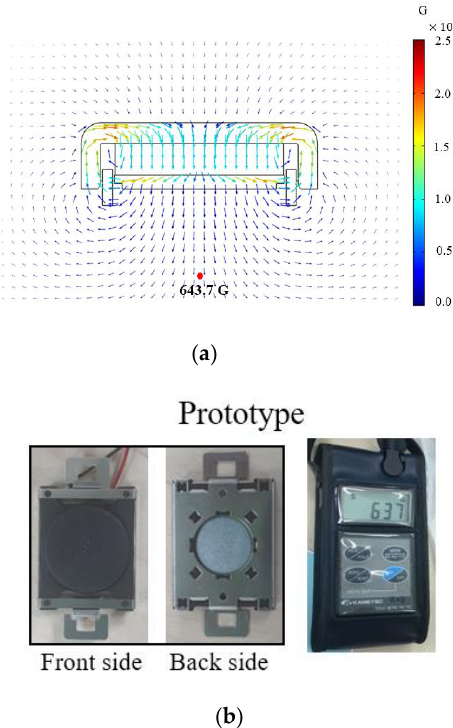
Figure 5. Magnetic flux leakage of the prototype: ( a ) analysis result; ( b ) experiment results.